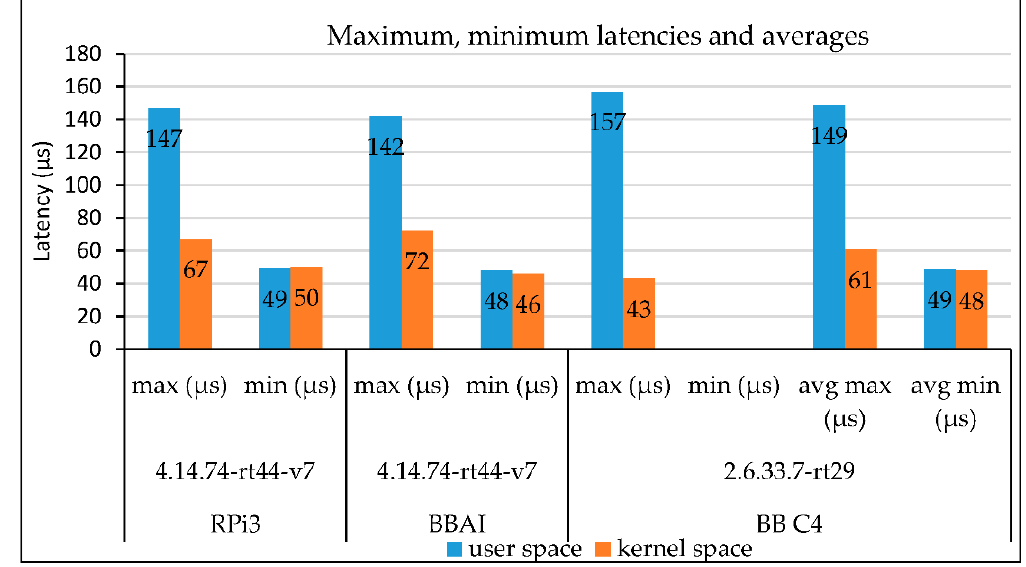
Figure 10. Maximum, minimum latencies and averages for preempted kernels at user and kernel space in all